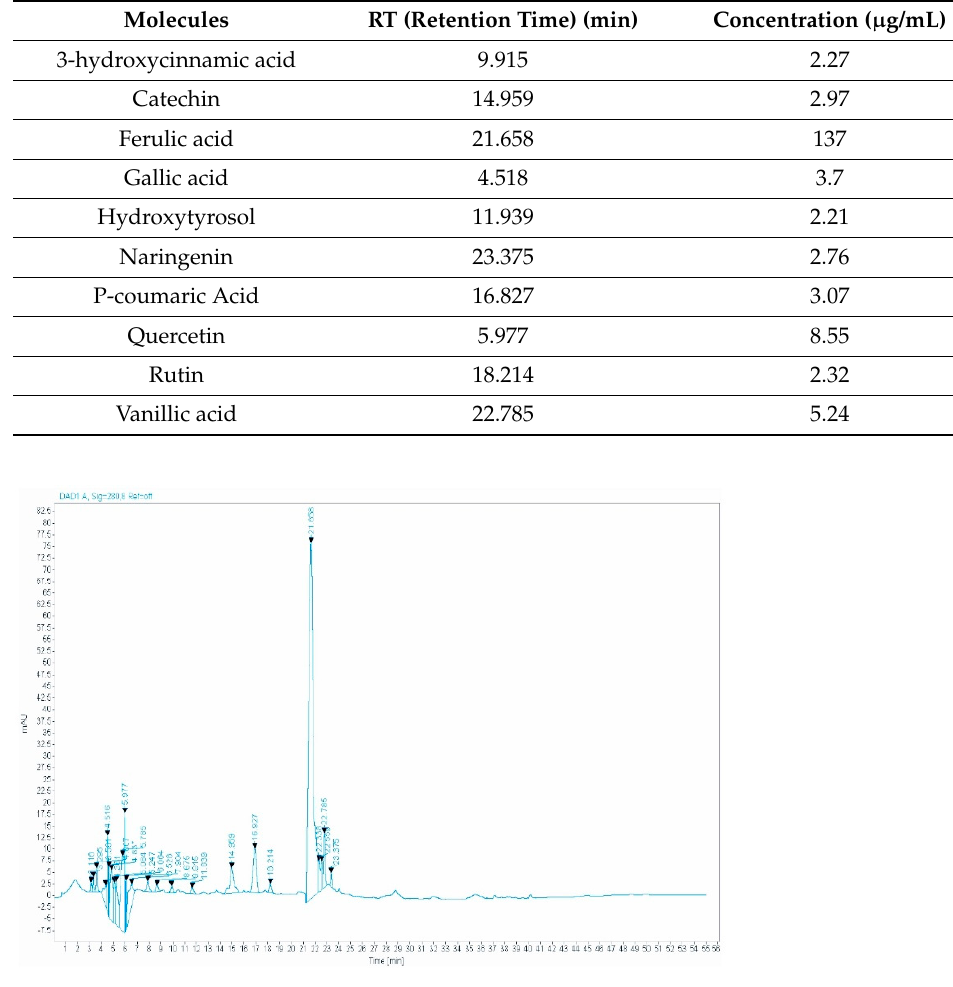
Figure 1. The HPLC chromatogram of ZLF aqueous extract. Table 1. HPLC–DAD data of the polyphenolic compounds detected in ZLF aqueous extract.